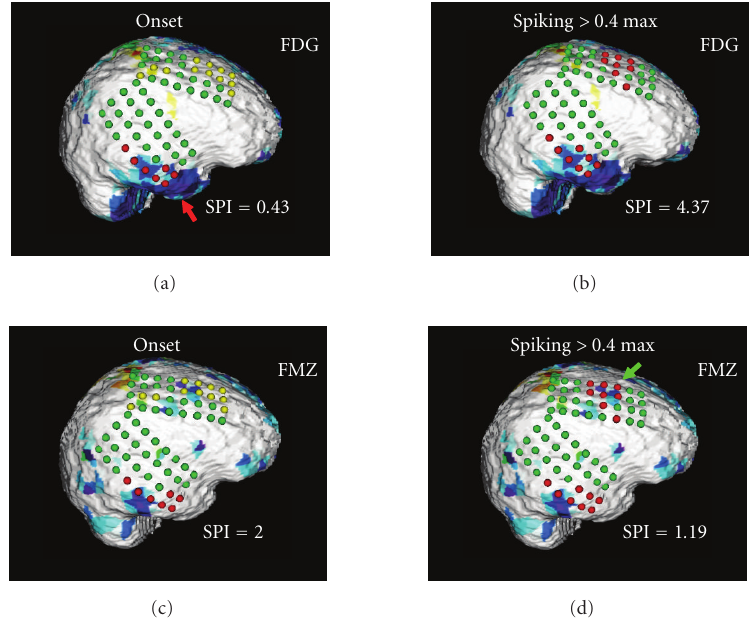
Figure 8: Cortical display of a patient studied with both FDG PET (panels (a) and (b)) and FMZ PET (panels (c) and (d)). Images on the left (panels (a) and (c)) show coding of the EEG grid according to the location of seizure onset electrodes (red) and seizure spread electrodes (yellow). The images indicate that the FDG PET abnormality corresponding to seizure onset electrodes in the temporal lobe (red arrow) is larger than the FMZ PET abnormality. Moreover, in the case of FDG PET, the seizure onset electrodes overlay a larger functionally abnormal area as compared to FMZ PET which is reflected in the lower SPI score for FDG (0.43 versus 2). The panels on the right (panels (b) and (d)) present the coding of the EEG grid according to a spike frequency threshold of 40% of the maximal spike frequency observed in this patient. Whereas FMZ PET is sensitive to the area of high spike frequency in the frontal lobe (green arrow), FDG PET fails to detect this abnormality. Again, this spatial relationship between functional and electrophysiological abnormalities is encoded in the SPI score (1.19 versus